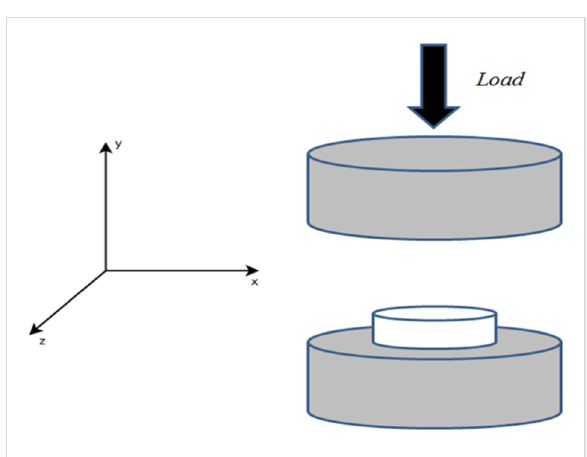
Figure 1: Schematic of uniaxial compression test of a zeolite pellet along the y -axis.